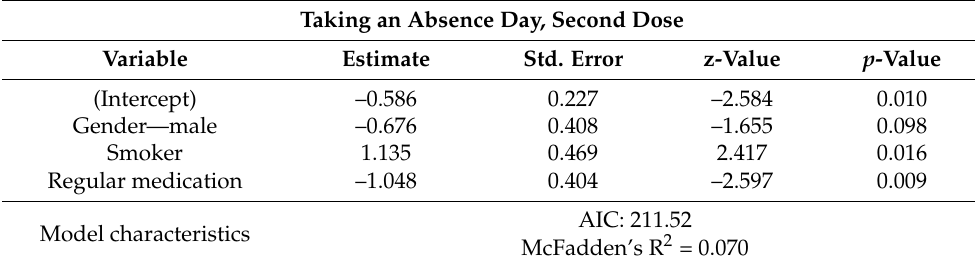
Table 8. Logistic model results for taking an absence day after second dose.